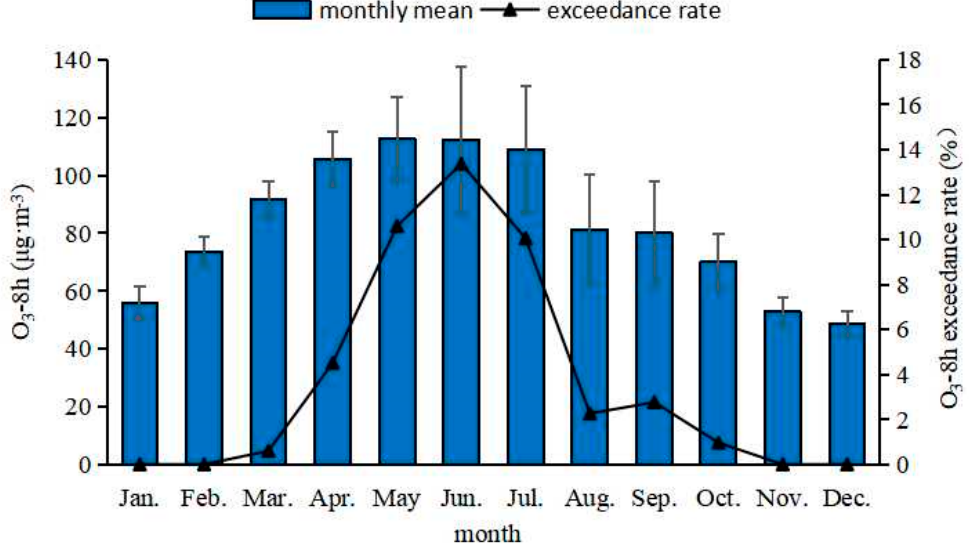
Figure 4. Monthly concentrations and over-standard rates of O 3 -8 h from 2017 to 2020 in Northeast China.